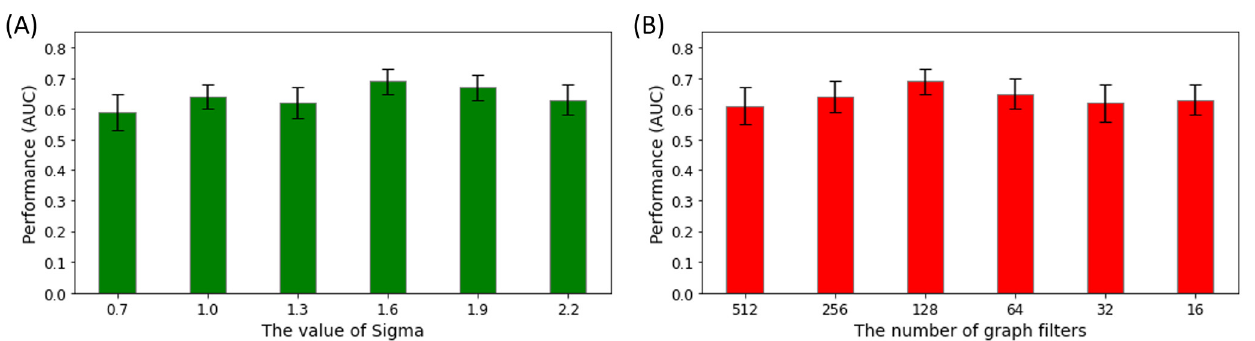
Figure 4. The model performance of the graph convolutional network model using ( A ) various edge weight coefficients for initial cohort graph construction and ( B ) different numbers of graph convolutional filters in individual layers.